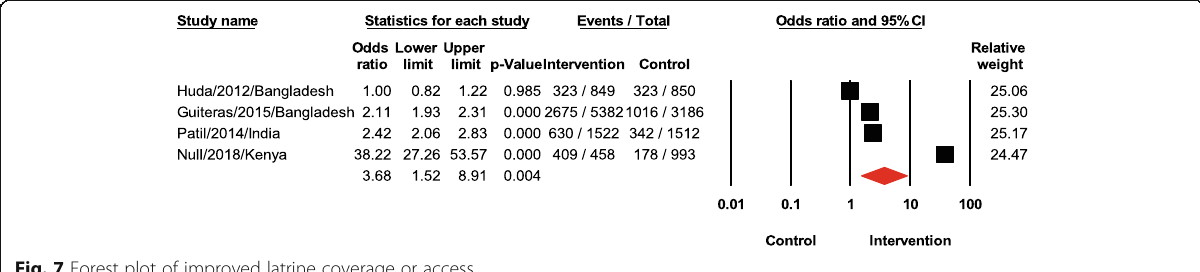
Fig. 7 Forest plot of improved latrine coverage or